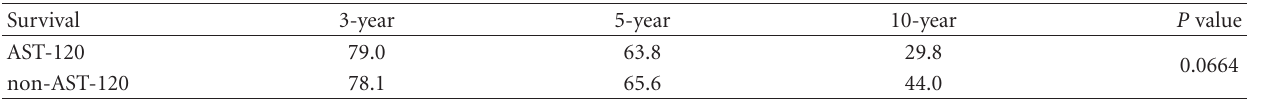
Table 6: The 3-, 5-, and 10-year survival rate of pair-matched patients. The 3-, 5-, and 10-year survival rates from administration of AST-120 were analyzed by the Kaplan-Meier method with a log-rank test. Survival rates at 3-, 5-, and 10-years were not significantly di ff erent in the AST-120 and non-AST-120 groups.